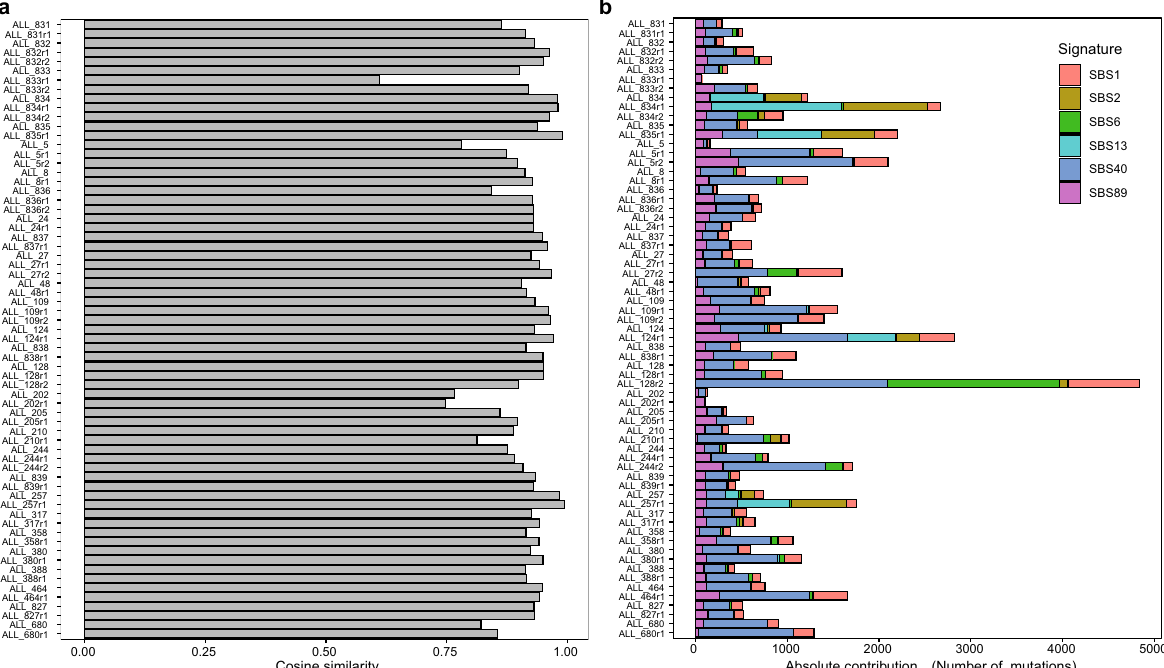
Figure2. Contribution of single-base mutational signatures to individual ALL samples. (a) The cosine similarities between observed mutations and mutations reconstructed using the set of six COSMIC mutational signatures (SBS1, SBS2, SBS6, SBS13, SBS40 and SBS89) for each of the 67 individual ALL genomes. The four samples with the lowest cosine similarities (ALL_833r1, ALL_202r1, ALL_202, ALL_5; cosine similarity < 0.8) are the four samples with the lowest number of mutations. (b) The contributions of six COSMIC signatures to 67 ALL samples. ALL sample identities are shown on the vertical axis, with first and second relapse shown by r1 and r2. The number of mutations in each sample is shown on the horizontal axis, and mutations are colored according to the associated COSMIC mutational signatures in the figure insert. Six samples at diagnosis or first relapse (ALL_834, ALL_834r1, ALL_835r1, ALL_124r1, ALL_257 and ALL257r1) harbored large numbers of mutations associated with the AID/APOBEC mutational signatures (SBS2 and SBS13). Three patients (ALL_834r2, ALL_27r2 and ALL_128r2) harbored mutations associated with SBS6 indicative of defective DNA mismatch repair at second Table S4) as defined in lymphoblastoid cell lines (LCLs) or in primary ALL cells 24,25 . Non-coding somatic SNVs and indels were considered to be in the same genomic region if they were present within the same 100 base pair (bp) region in at least two patients with ALL. This analysis detected potential cis -acting SNVs in regulatory regions of eight genes in 18 patients at diagnosis and/or relapse (Fig. 3, Supplementary Table S4). Ten of the SNVs were located in the first intron/5’UTR of CHRAC1 , GATAD2B, MYO9A , CSK or PALM2-AKAP2 , two SNVs were located in the fifth intron of MSI2 , and two SNVs were located in an intergenic region 23 kb and 234 kb downstream of ZNF648 and CACNA1E , respectively (Fig. 3). With the exception of the CSK gene , the putative regulatory SNVs were located within a < 20 bp hotspot region (size range 5–19 bp) in each gene, which suggests that they are part of the same regulatory element (Fig. 3). Four of the non-coding SNVs were mutated in two patients at exactly the same genomic position. These SNVs were in the CHRAC1, PALM2-AKAP2 and ZNF648/CACNAE1 genes (Fig. 3), which further supports a functional role for them in ALL. Since driver genes often are disrupted by different mechanisms in different patients, coding mutations identi- fied in other patients add support to the functional effect of mutations in cis -acting regulatory elements of a gene. The relevance of CACNA1E was in our cohort supported by a missense mutation in one patient in addition to the three patients with non-coding mutations. Moreover, more than 2% of ~ 5000 samples from patients with haematopoietic and lymphoid cancers included in the COSMIC Release v94 database carried coding mutations in MYO9A, PALM2-AKAP2, MSI2 or CACNA1E (range 121–202 mutated samples per gene) (Supplementary Table S4). Each of the seven genes with non-coding somatic mutations were expressed in the patient carrying the putative regulatory non-coding variant with log2 of FPKM (fragments per kilobase per million mapped reads) value > 1 (Supplementary Table S4). We used the cis - eXpression (cis-X) tool 26 to further evaluate the regulatory role of the non-coding variants in the affected samples, and report allele specific expression (ASE) and outlier high expression (OHE). ASE and OHE did not provide additional support for a cis -acting role for non-coding variants in our samples (Supplementary Table S4).